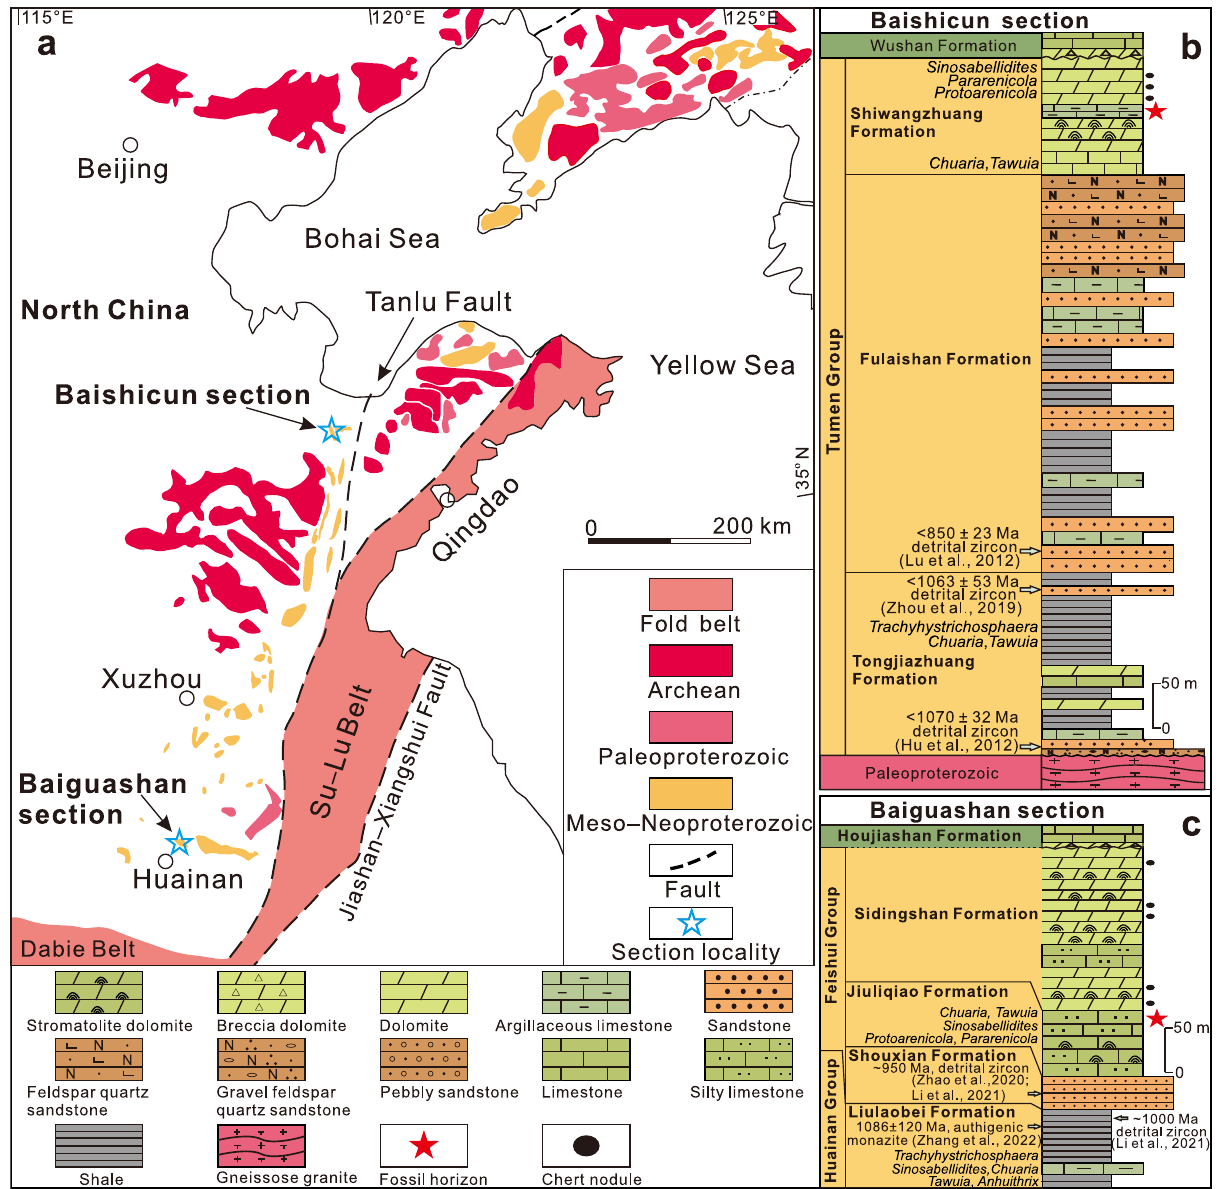
Fig. 1 Geological map and stratigraphic columns of Baishicun and Baiguashan sections, North China. a Geological map showing distribution of Precambrian strata in eastern North China Craton, with stars denoting locations of Baishicun and Baiguashan sections. Geological map is modi fi ed from refs. 84, 86 . b Stratigraphic column of Baishicun section in Anqiu region, western Shandong Province, modi fi ed from ref. 83 . Youngest detrital zircon ages from refs. 87 – 89 provide maximum age constraints. Biostratigraphic data are mainly from ref. 83 . c Stratigraphic column of Baiguashan section in Huainan region, northern Anhui Province. Youngest detrital zircon age populations are from refs. 90, 91 ; authigenic monazite SIMS Pb-Pb age is from ref. 92 ; biostratigraphic data are mainly from ref. 84 . See Supplementary Note 1 for a detailed stratigraphic